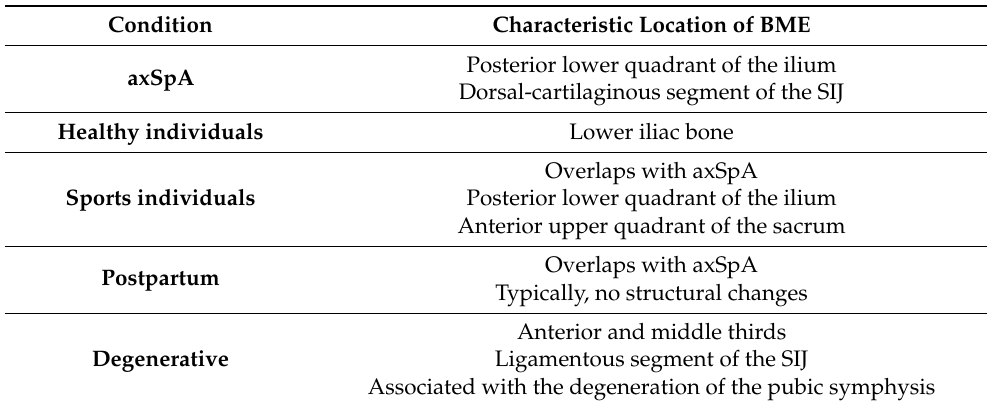
Table 5. Differential diagnosis of inflammatory from non-inflammatory back pain based on the typical location of BME. Condition Characteristic Location of BME Posterior lower quadrant of the ilium axSpA Dorsal-cartilaginous segment of the SIJ Healthy individuals Lower iliac bone Overlaps with axSpA Sports individuals Posterior lower quadrant of the ilium Anterior upper quadrant of the sacrum Overlaps with axSpA Postpartum Typically, no structural changes Anterior and middle thirds Degenerative Ligamentous segment of the